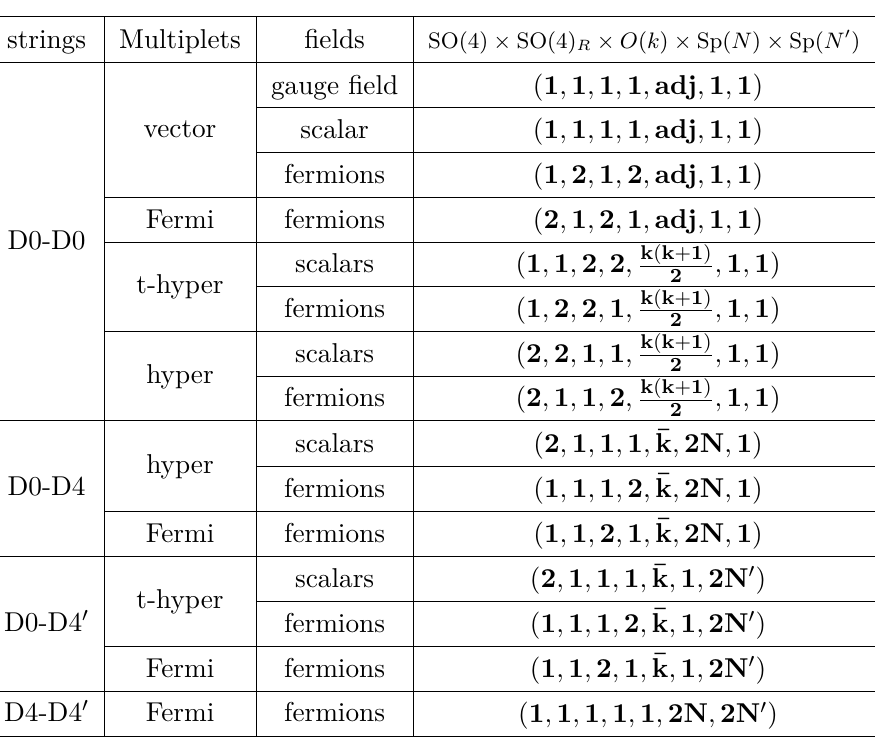
Table 6 . The field content of the quantum mechanics. O ( k ) = b G is the D0 brane group, Sp( N ) = G is the D4 brane group and Sp( N 0 ) = G 0 is the D 4 0 brane group. SO(4) = SU(2) − × SU(2) + , SO(4) R = SU(2) R × SU(2) R . Of interest to us is the case of a single D 4 0 brane, N 0 = 1 . t-hyper − + denotes a (0 , 4) twisted